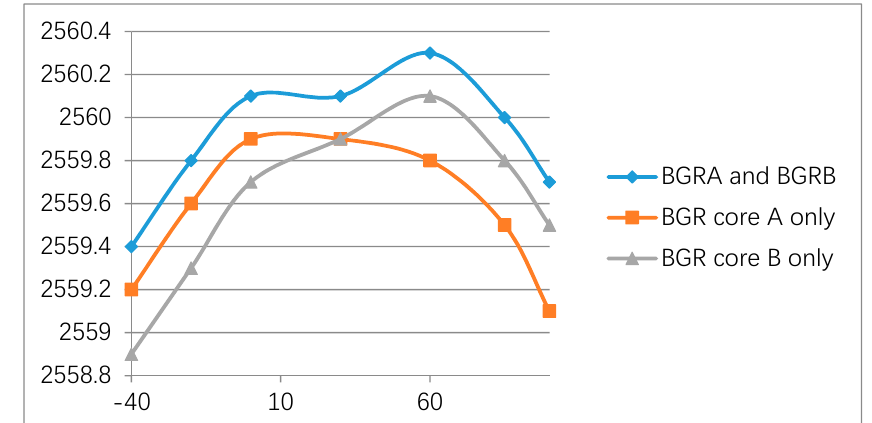
Figure 13. Bandgap reference test results.